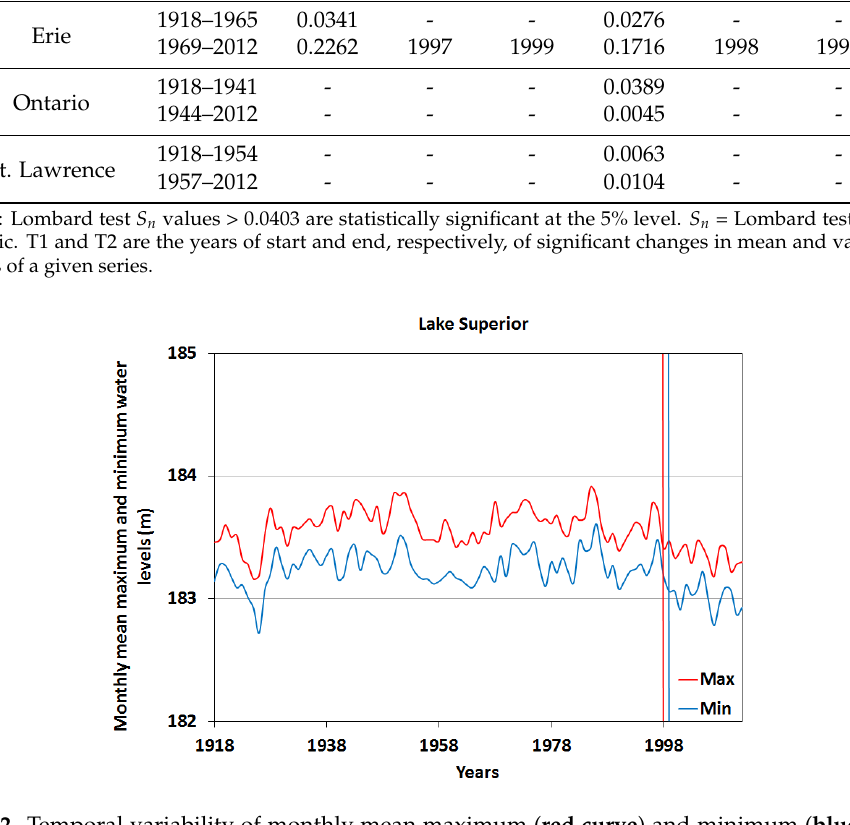
Figure 2. Temporal variability of monthly mean maximum ( red curve ) and minimum ( blue curve ) water levels in Lake Superior (1918–2012). The vertical lines represent the timing of the shift in mean values of the series.